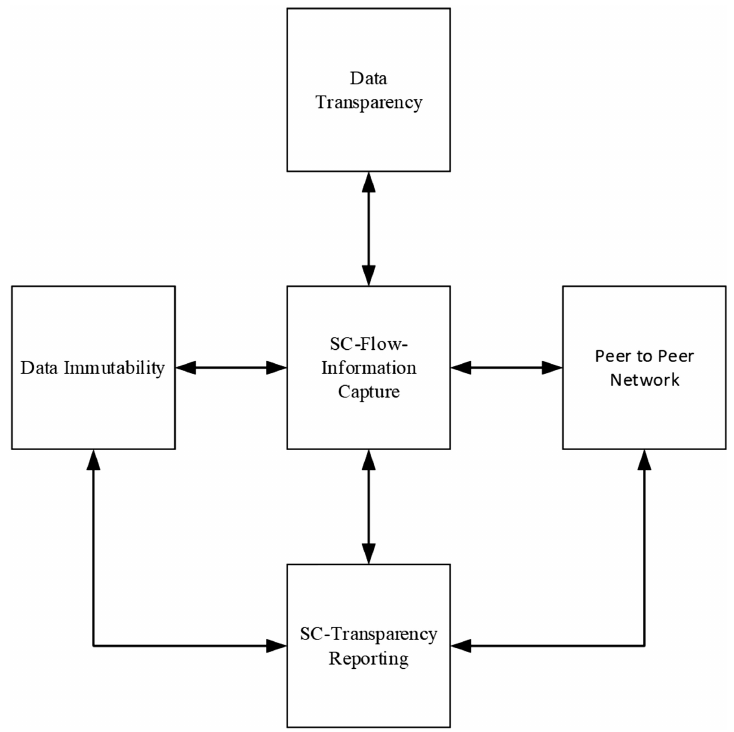
Figure 3. Blockchain traceability